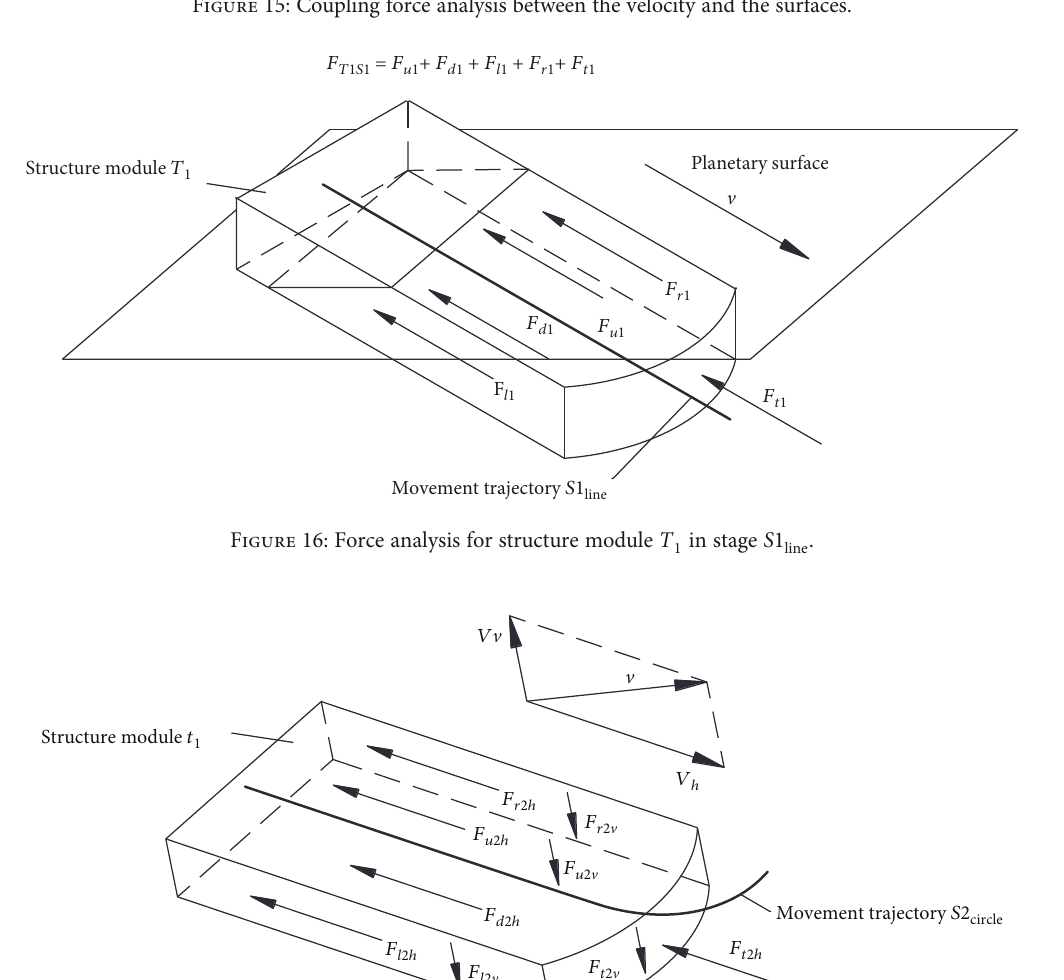
Figure 17: The force analysis for structure module T